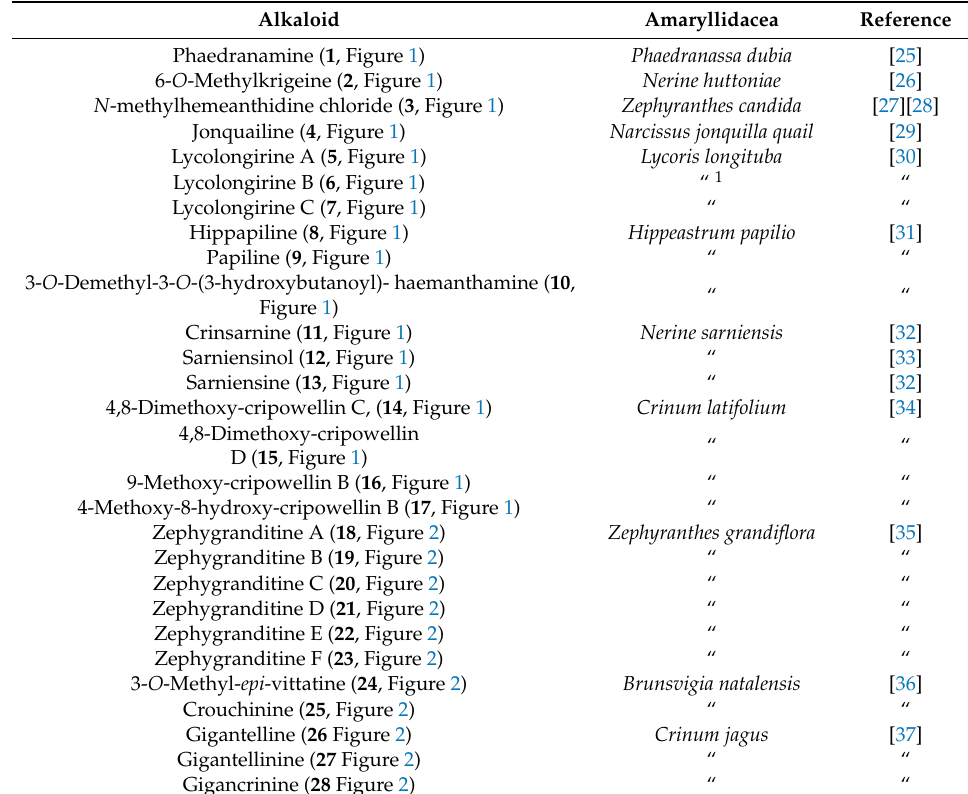
Table 1. Amaryllidaceae alkaloids and natural analogues isolated in the last